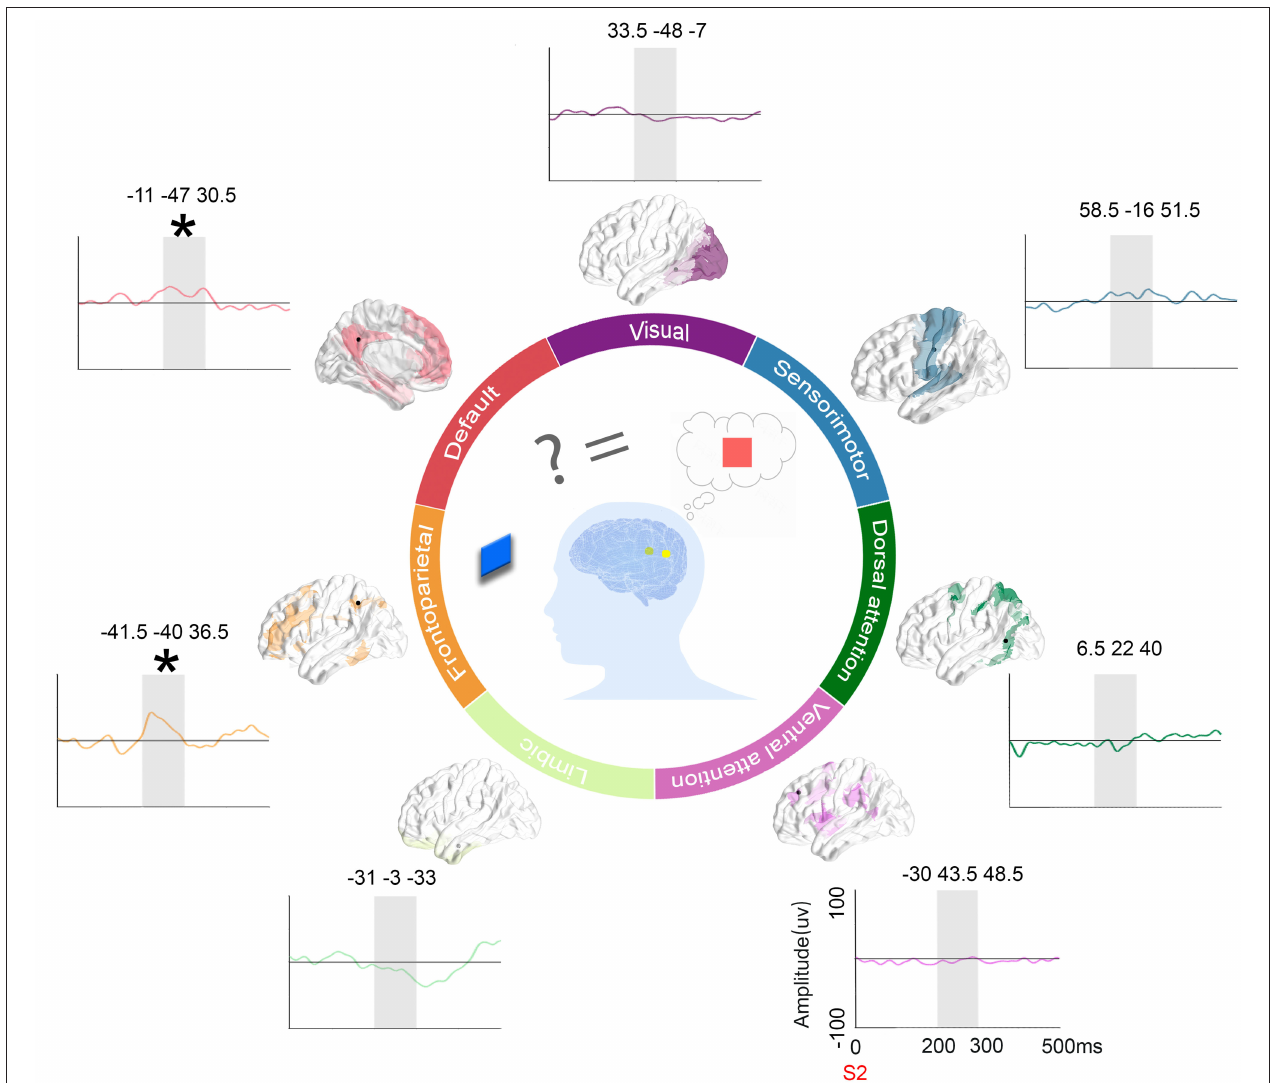
FIGURE 7 | ERPs on representative contacts over different functional networks and schematics. Location of contacts: the black dot represents the contacts on the parcellation maps of the 7 functional networks. Subtract ERPs morphology: the mean ERP amplitude of the congruent condition subtracted from the other incongruent conditions (orange: the congruent condition vs. irrelevant incongruent condition, green: the congruent condition vs. relevant incongruent condition, and purple: the congruent condition vs. conjunction incongruent condition) in the time window of interest (200–300ms in gray shadow) in 7 networks. Schematic figures: The schematic picture shows the activation when people need to integrate incoming extrinsic information (red square) with prior intrinsic information (blue